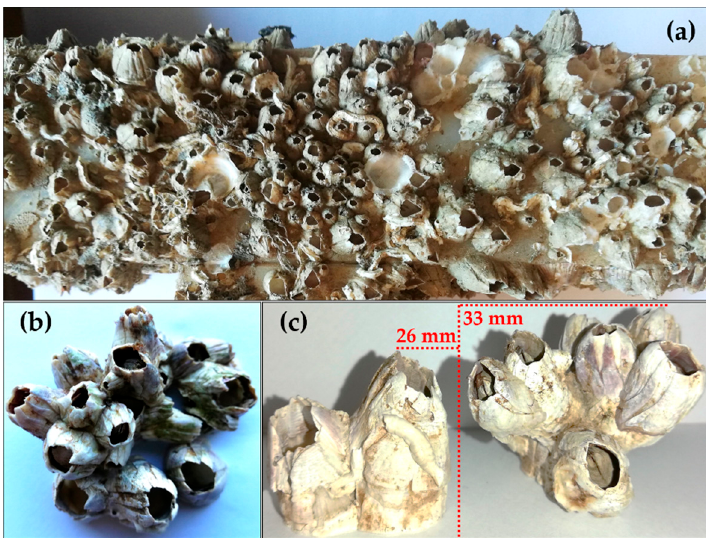
Figure 5. Acorn barnacles ( Perforatus perforatus ) growing on a nylon structure: ( a ) barnacles found on a marina walkway; ( b ) top view detail; and ( c ) side view detail, with an individual measuring 26 mm tall and a clump measuring 33 mm tall.